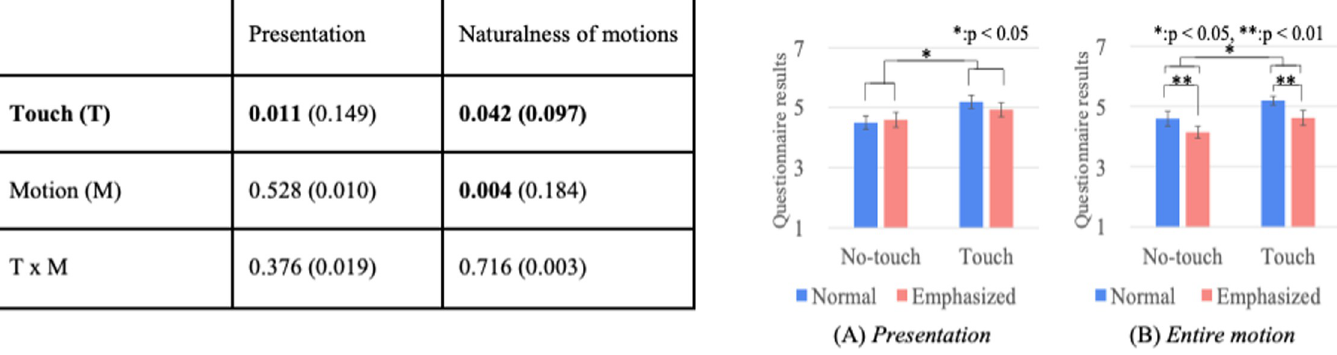
Fig 7. Descriptions of robot’s presentation and naturalness toward motions.